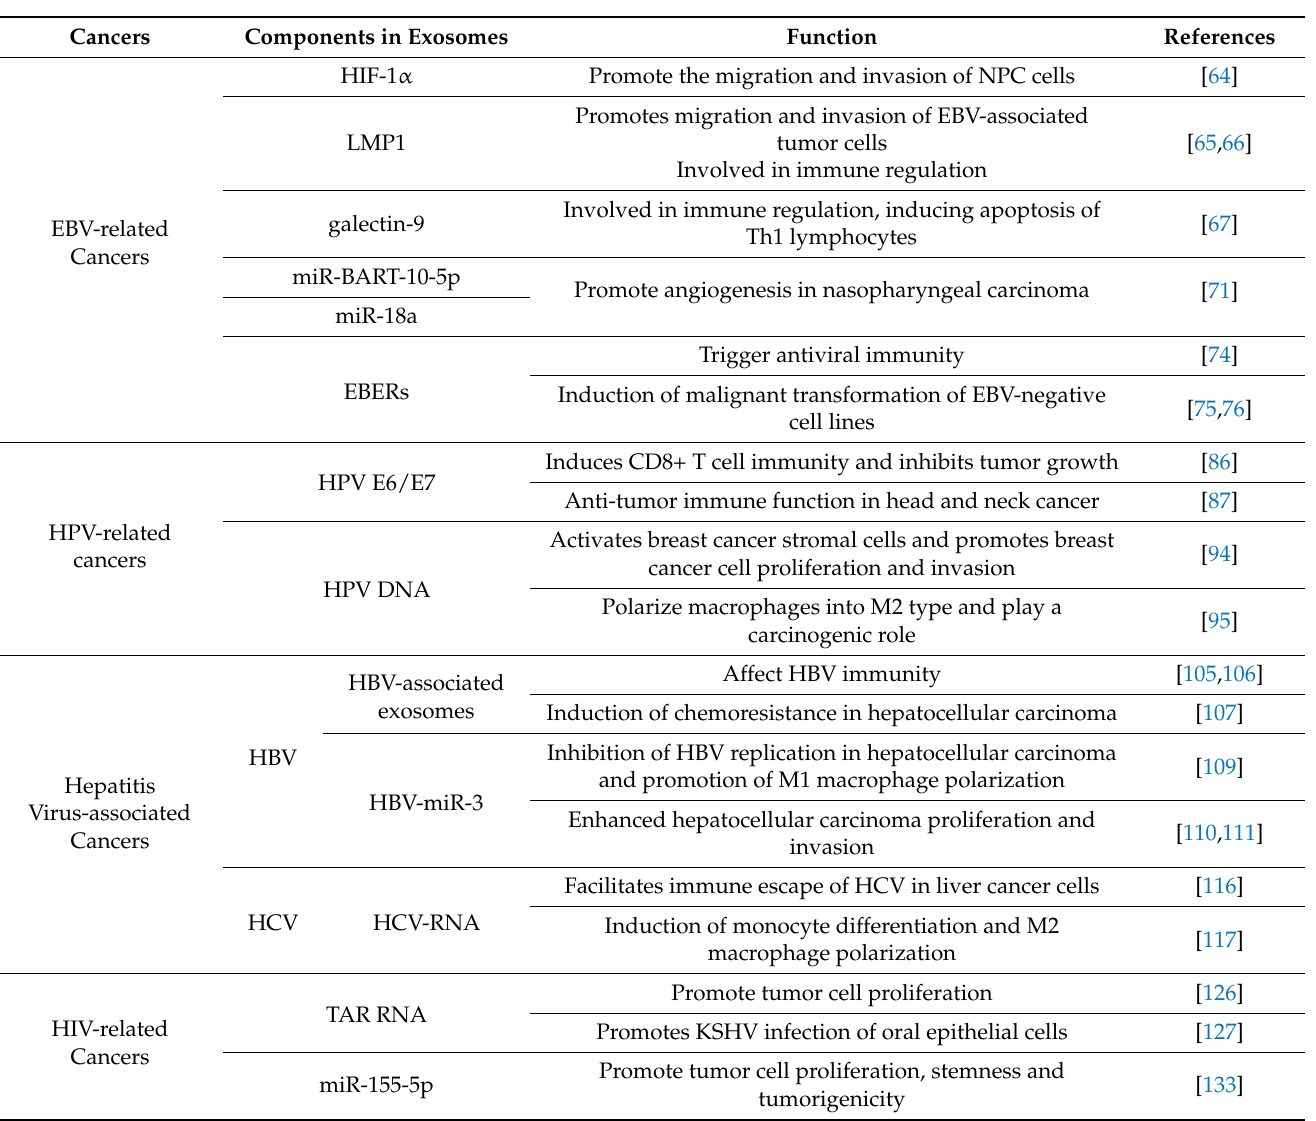
Table 1. Effects of exosomes secreted by virus-associated tumor cells on the tumor microenvironment. The components and their functions in virus-related tumor exosomes mentioned in the article are listed in the